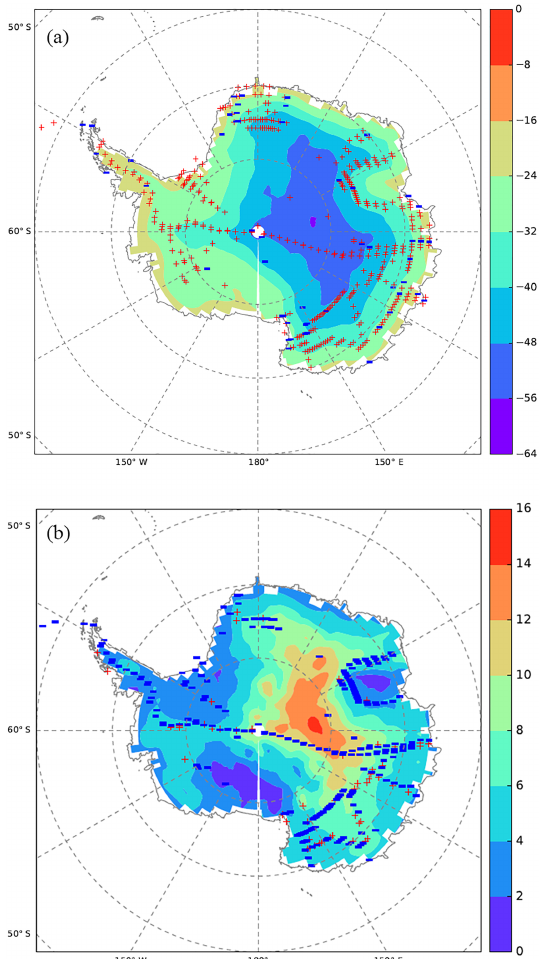
Figure 5. Maps displaying model–data comparisons for δ 18 O time- averaged values (a) and inter-annual standard deviations (b) . Back- grounds correspond to ECHAM5-wiso simulations over the period 1979–2013, while signs correspond to the model–data comparison. For the time-averaged values, the comparison consists of calculat- ing the model–data differences. Red “ + ” symbols indicate a posi- tive model–data difference, while blue “ − ” symbols correspond to a negative model–data difference. For the inter-annual standard de- viations, the comparison consists of calculating the ratio of the sim- ulated value to the corresponding grid cell data. Red “ + ” symbols indicate a ratio higher than 1, while blue “ − ” symbols correspond to a model / data ratio lower than 1.